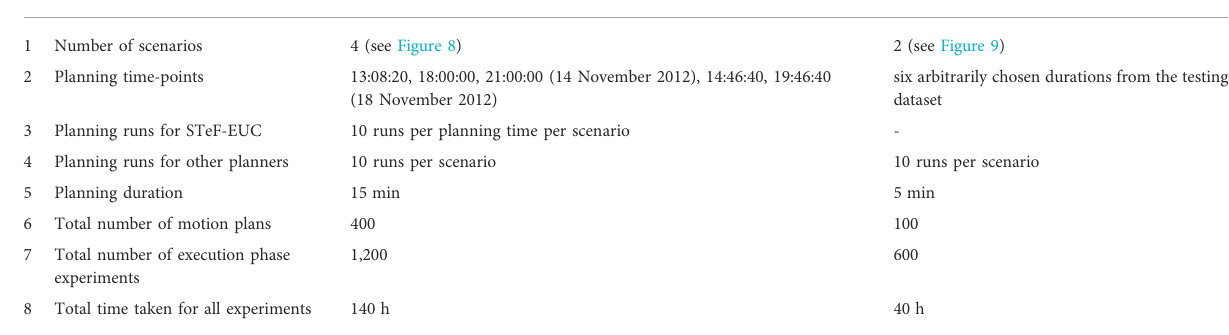
TABLE 3 Summary of experiments in the PedSim and ATC environments.